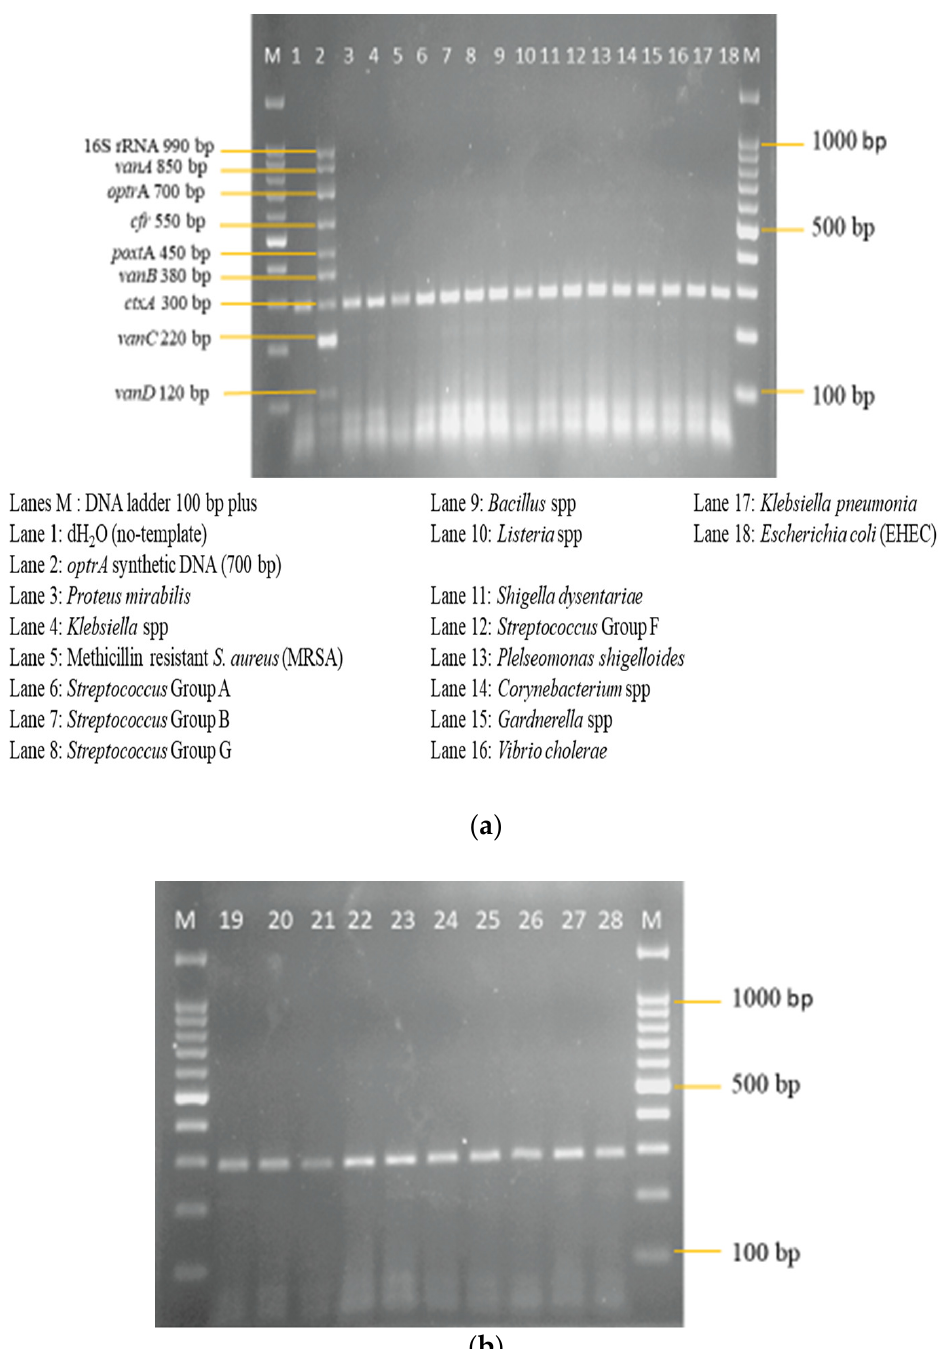
Figure 10. ( a ) Specificity evaluation of multiplex PCR assay on non-intended clinical isolates ( n = 16). Amplification is absent except for the IAC, indicating the specificity of the multiplex PCR assay; 300 bp ctx A doubles as the negative control and IAC on lane 1, while lane 2, with all targets, was designated as the positive control. ( b ) Specificity evaluation of multiplex PCR assay on non-intended clinical isolates ( n = 10) continued. Lane M: DNA ladder 100 bp plus. Lane 19: Escherichia coli (EPEC). Lane 20: Vibrio parahaemolyticus . Lane 21: Shigella sonnei . Lane 22: Shigella boydii . Lane